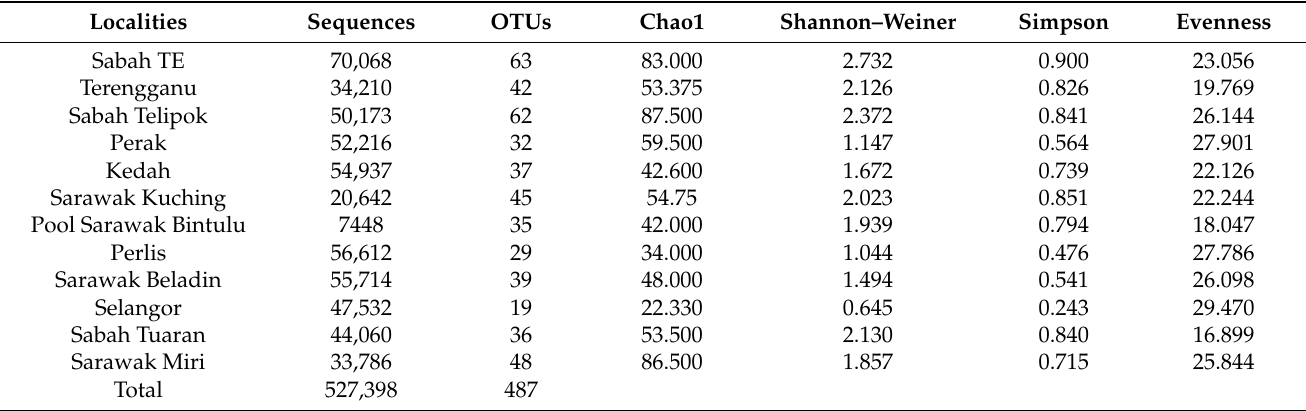
Table 2. The numbers of effective trnL gene sequences. Number of observed OTUs, alpha diversity indices for the plant DNA from 12 localities of H. itama. Localities